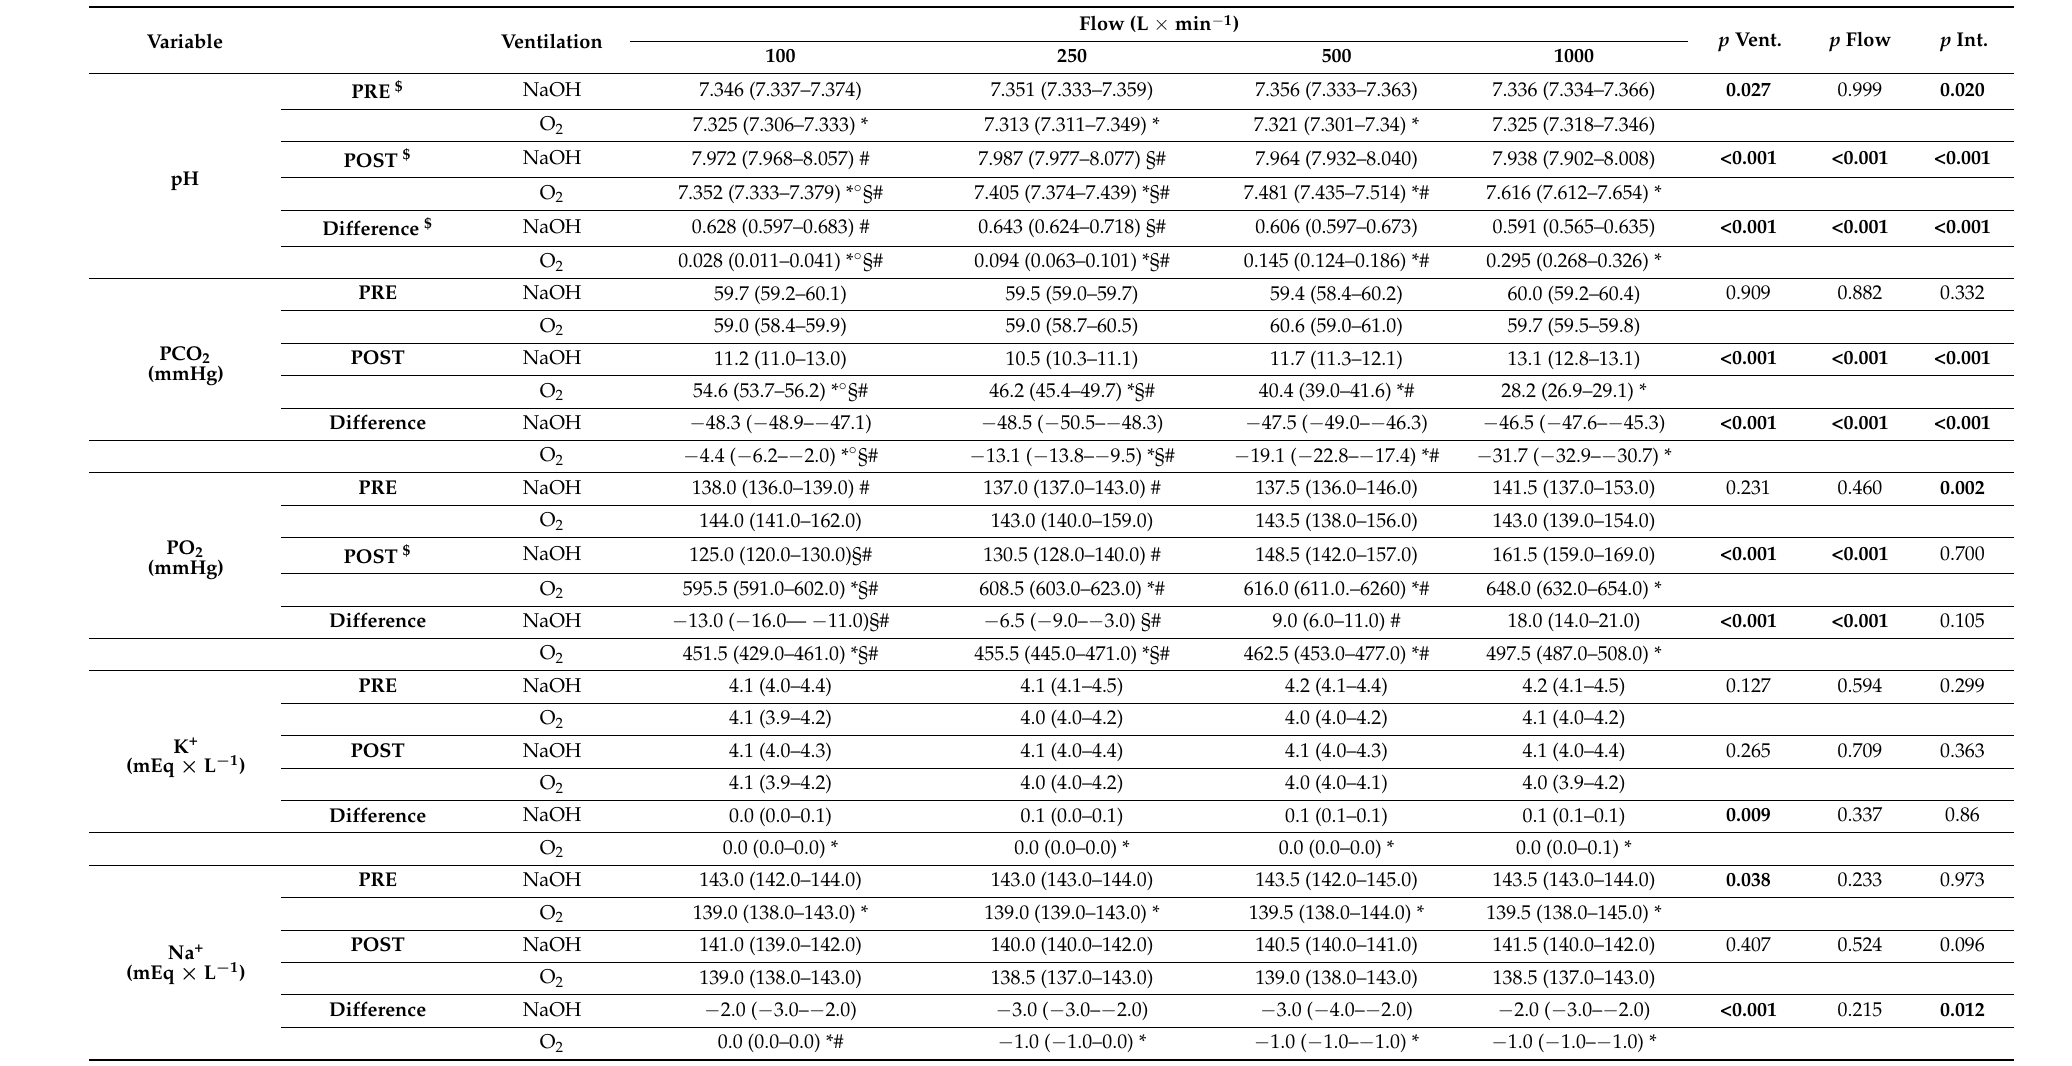
Table 1. Efficiency tests